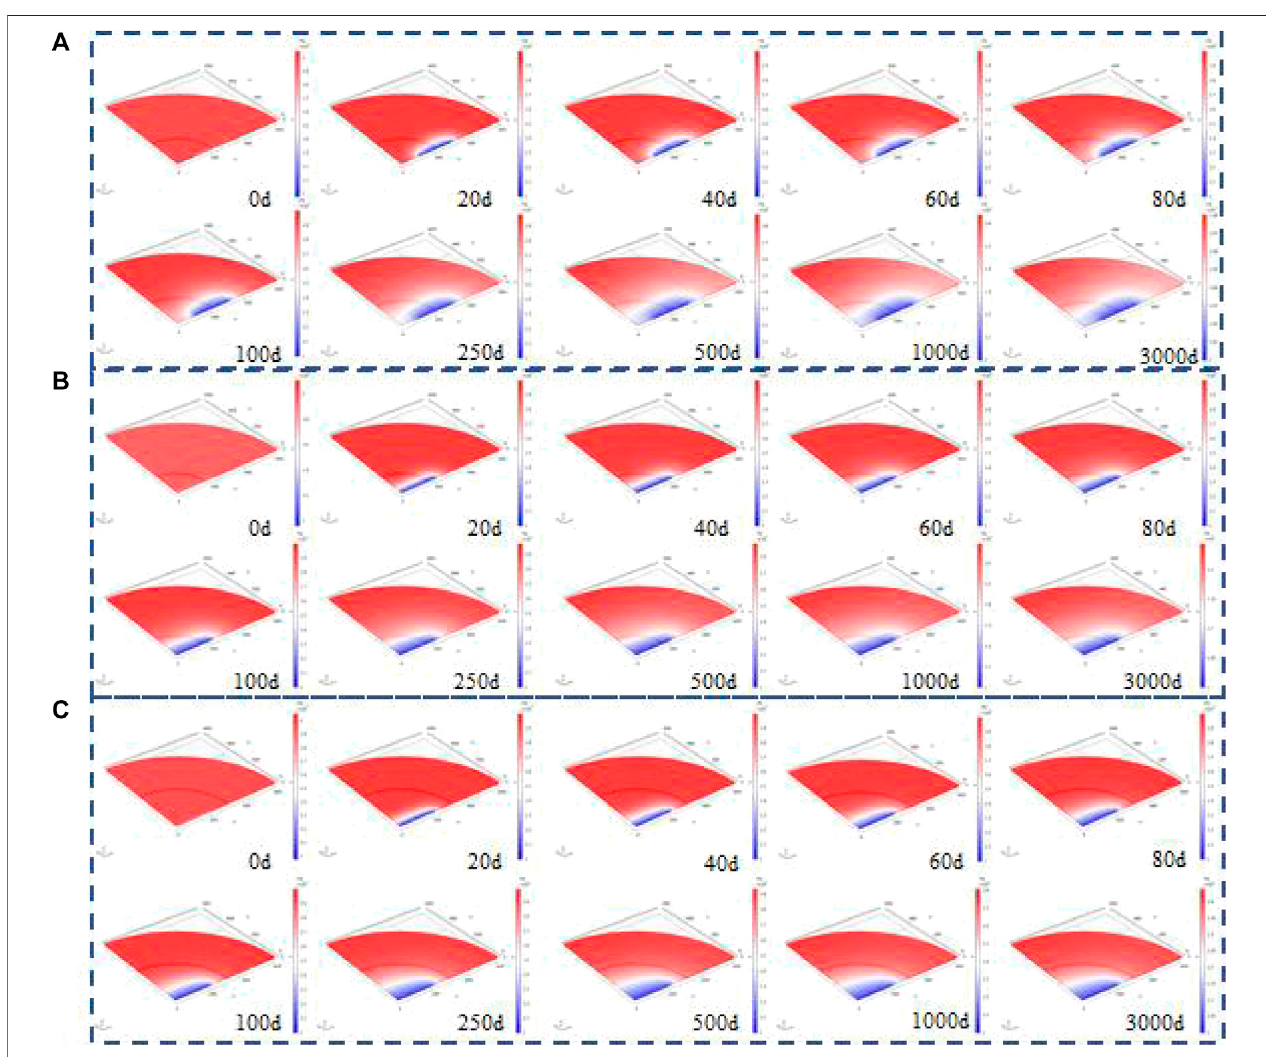
FIGURE 2 | Typical transient pressure distribution of (A) a horizontal well fully in the inner region, (B) a horizontal well passing through two regions on both sides, and (C) a horizontal well passing through two regions on a single side.